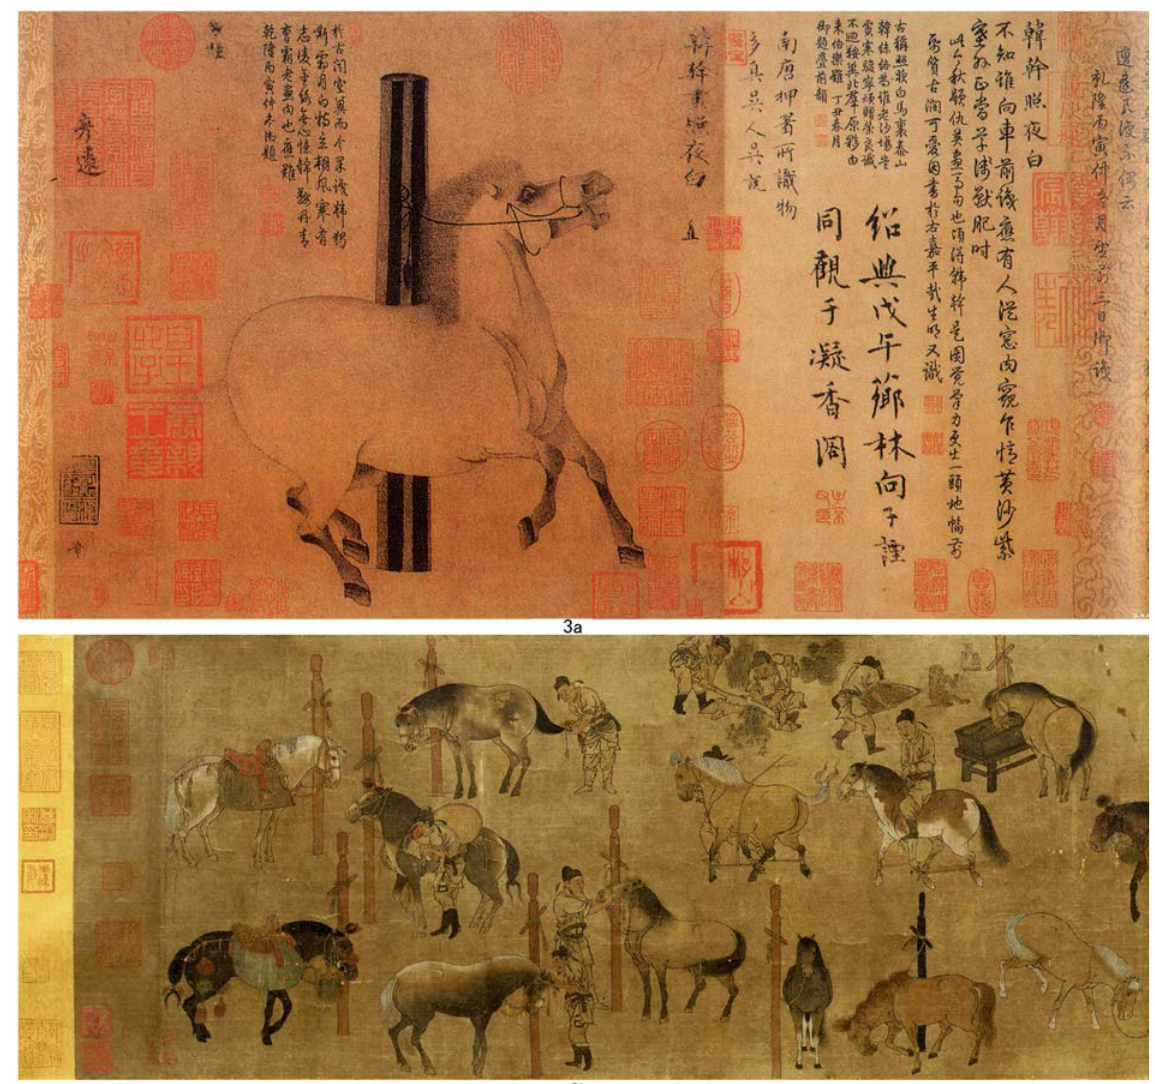
Figure 3. Paintings from the Tang Dynasty; a) Map of Zhao Yebai , Gan Han 706-783 CE; b) Map of Hundred Horses , Yan Wei (approx. 800